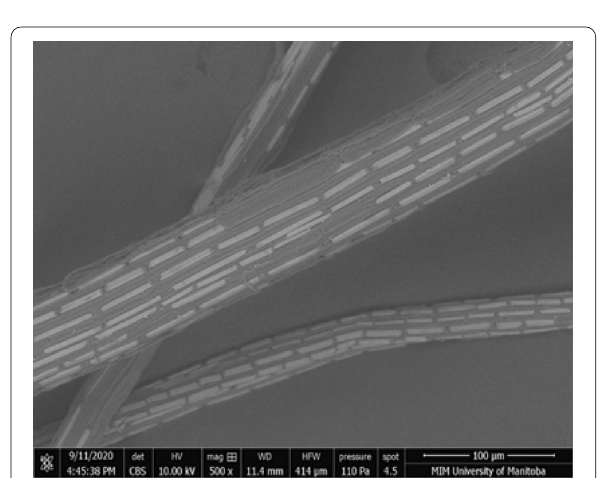
Fig. 6 SEM image of cattail fiber